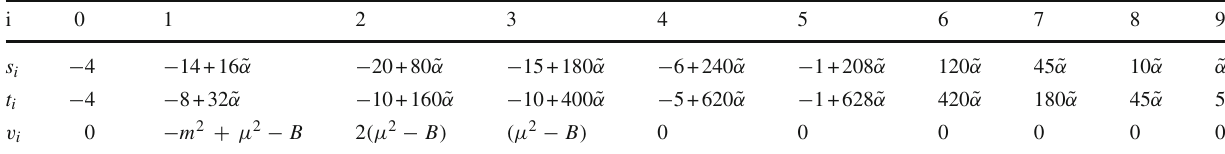
Table 1 Non-zero s i , t i and v i for marginal stable mode (ω = 0 ) of d = 5, ( q = 1 )